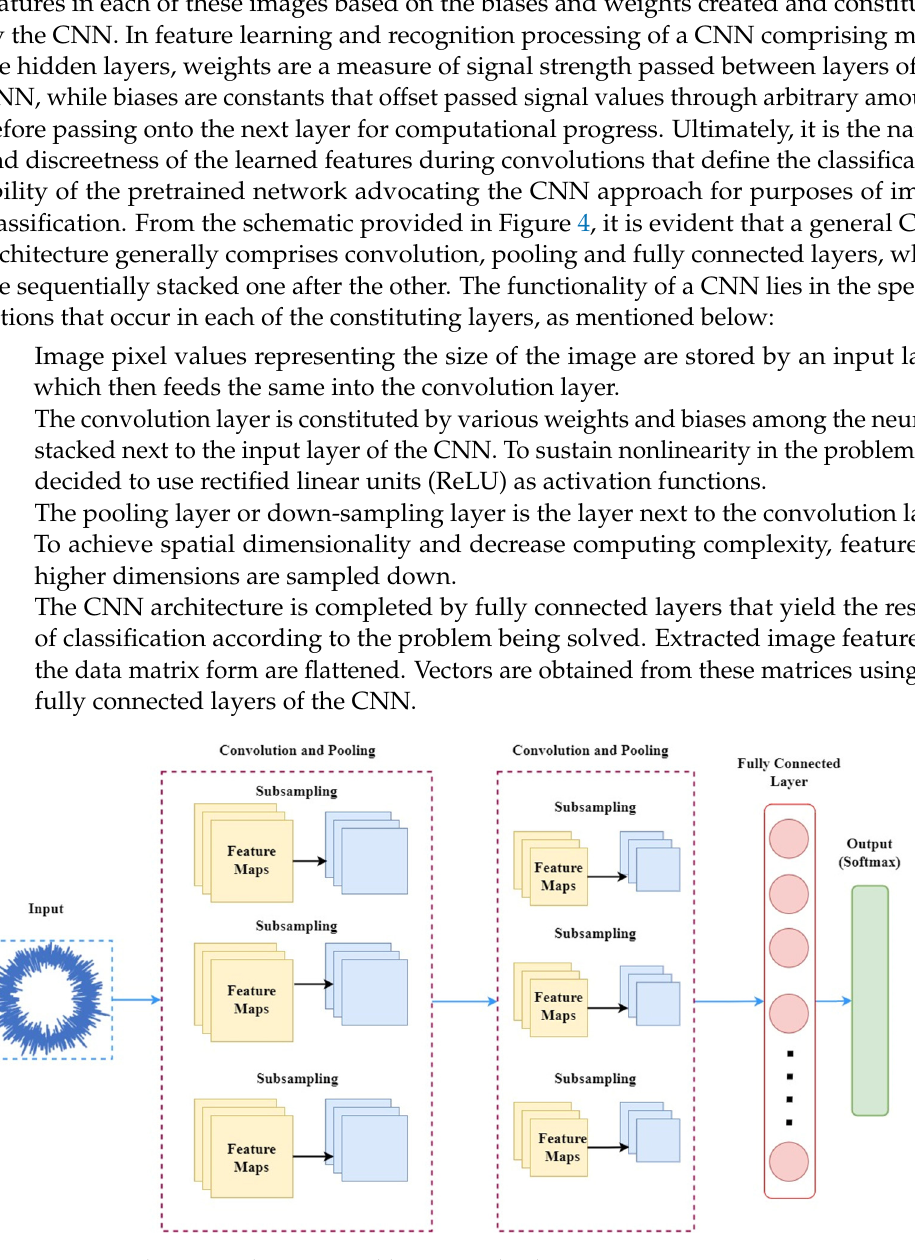
Figure 4. General CNN Architecture and layers involved.